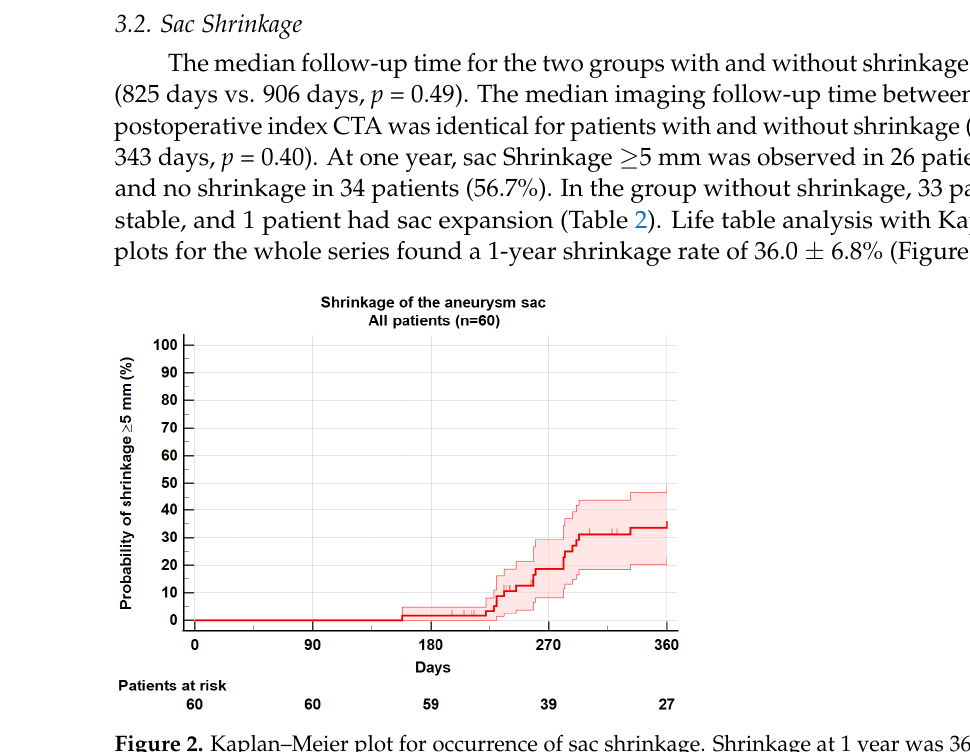
Figure 2. Kaplan–Meier plot for occurrence of sac shrinkage. Shrinkage at 1 year was 36.0 ± 6.8% for the whole series. Table 2. Main characteristics of 60 patients undergoing EVAR for infrarenal aortic aneurysm ac- cording to sac shrinkage ≥ 5 mm.